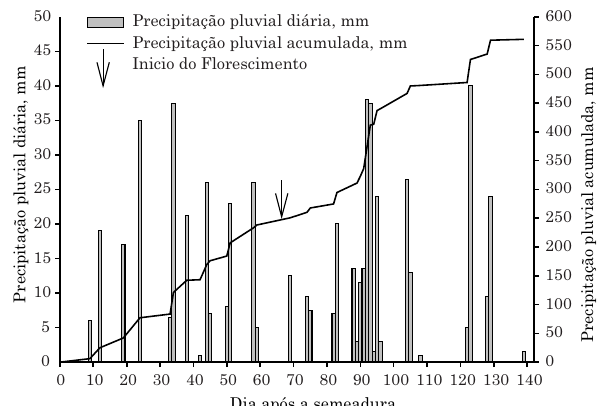
Figura 2. Precipitação pluvial diária e acumulada durante o ciclo da cultura da soja no ano agrícola 2008/09, no município de Victor Graeff, RS. Fonte: